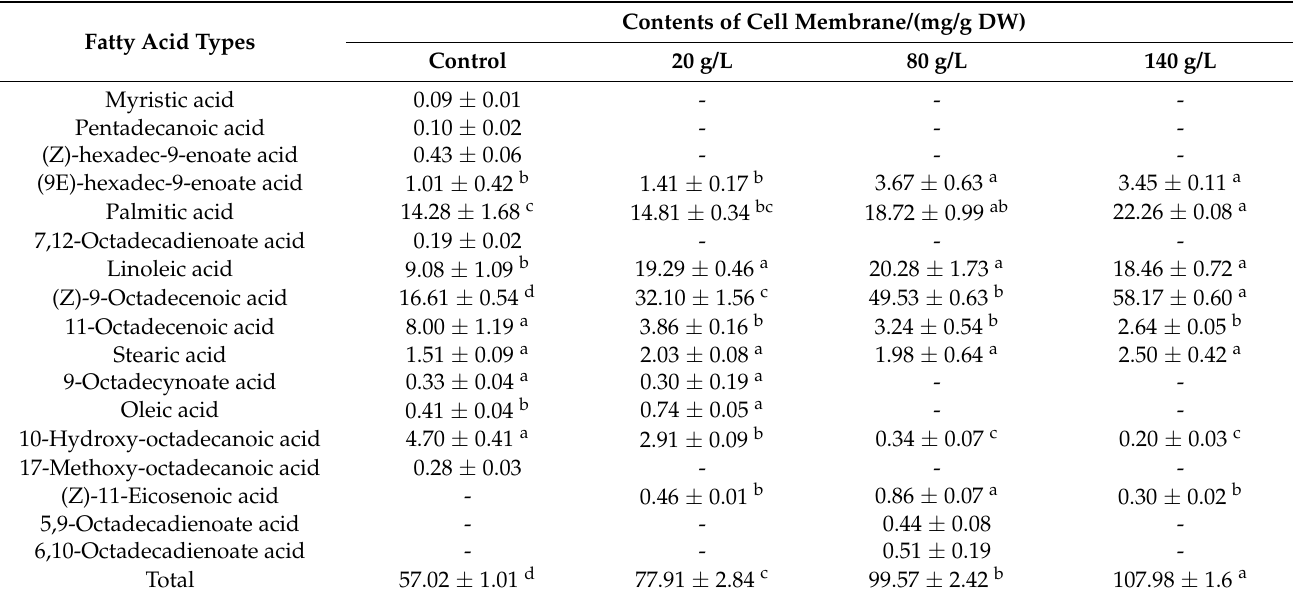
Table 1. Types and contents of fatty acids in cell membranes of I. terricola